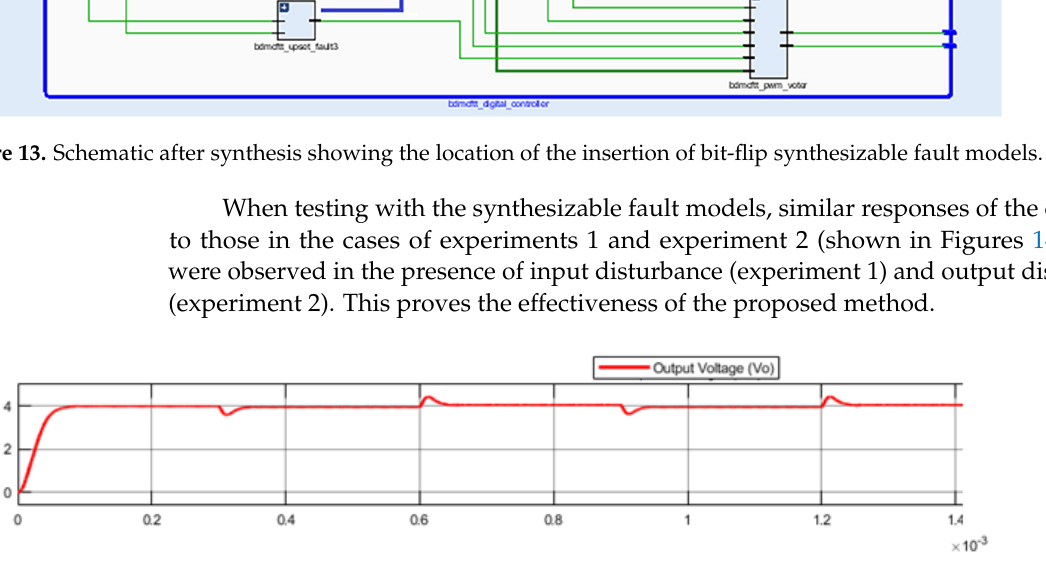
Figure 14. Converter output voltage response during input disturbances in the presence of radiation fault injection (experiment 1).